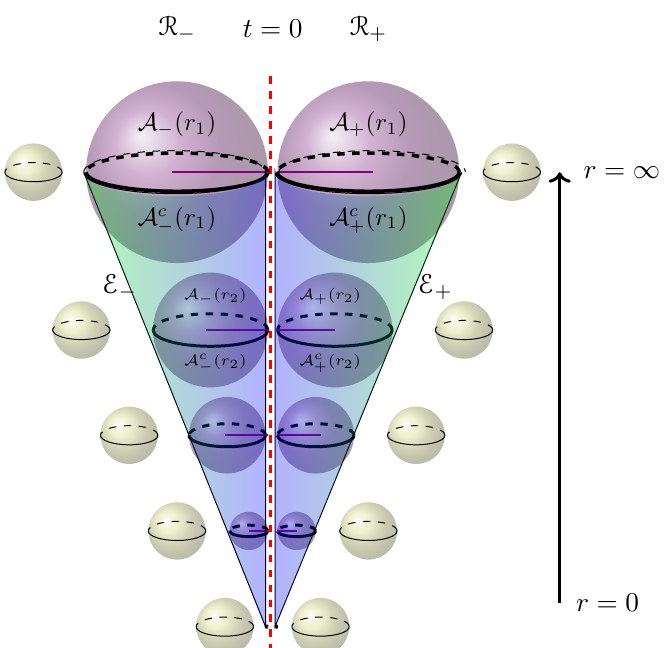
Figure 11 . The radial direction of the 3-balls in the pair ( B (cid:0) ; B + ), depicted by the violet lines in the (cid:12)gure, are taken to be the time direction. Splitting the resolved conifold at t = 0 involves de- composing it about the red dashed line that pass through the middle of the pairs of 3-balls, resulting in two geometries R (cid:6) as indicated. They are bounded by codimension-1 constant time surfaces (cid:0) (cid:6) (not shown explicitly) which comprise of an S 2 of radius r (boundaries of B (cid:6) , respectively), over which is (cid:12)bered a unit-radius S 2 . The entangling branes E (cid:6) have topology S 2 (1) (cid:2) S 1 (cid:2) ( R + [ f 0 g ) and will be discussed later in the